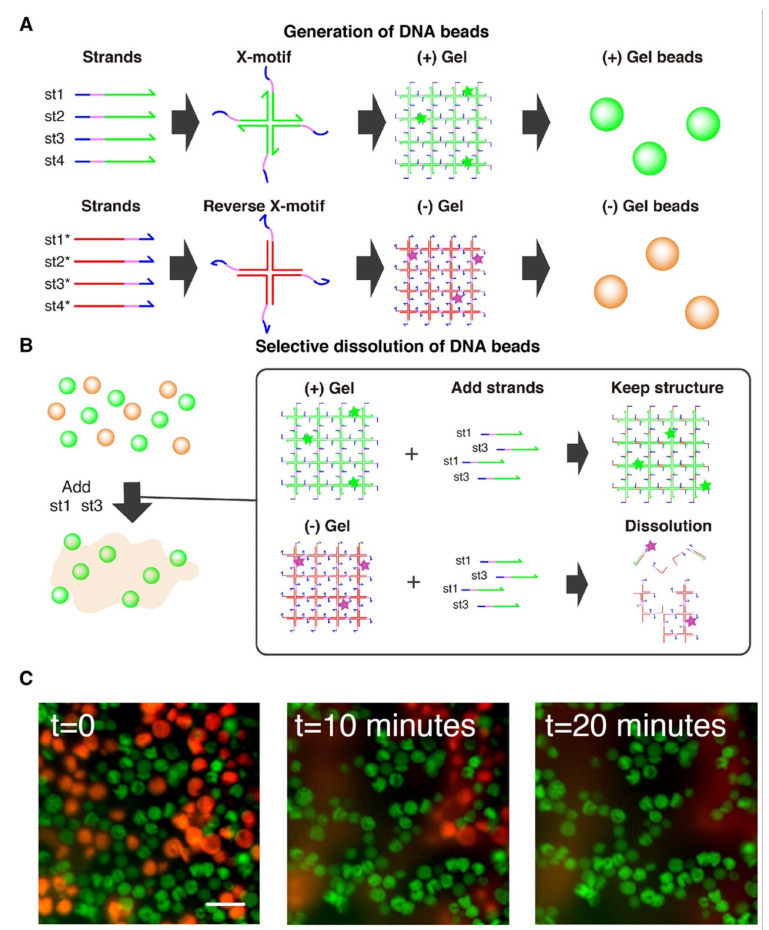
Figure 5. Selective dissolution of DNA gel beads. ( A ) Two populations of gel beads were generated with microfluidic. One population of (+) gel beads is made from strands st1, st2, st3, st4. The (-) population of gel beads is made of the exact complementary strands (st1*, st2*, st3*, st4*), which also form a gel. ( B ) Workflow for selective dissolution. The (+) and (-) population are mixed together, and st1 and st3 are added in large excess. These strands invade the X-motif of the (-) gels through their toehold (blue), causing the disruption of the motif and the dissolution of the gel. (+) gel beads are unaffected because they are inert with respect to st1 and st3. ( C ) Microscopy observation of population of (+) gel beads (in green) and (-) gel beads (in red). The t = 0 image shows the gels just after addition and pipetting of the strand st1 and st3. About 20 min after addition of st1 and st3, the quasi complete dissolution of (-) gel beads can be observed, while the (+) gels remain intact. The scale bar is 80 µ